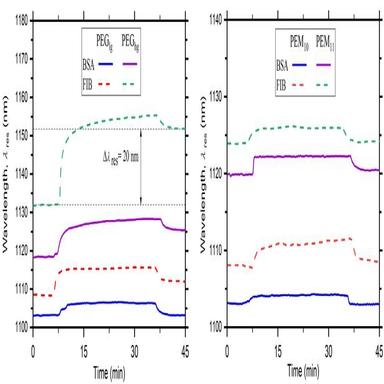
Protein adsorption on PEG (left) and PEM (right) surfaces from in situ SPR.